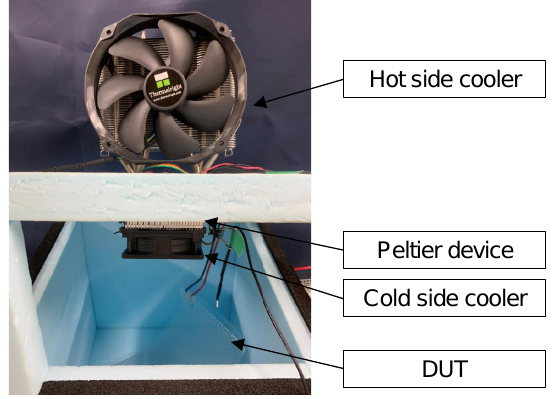
Figure 7. Realized experimental system [5]. The materials used in the calorimetric system are shown in Table